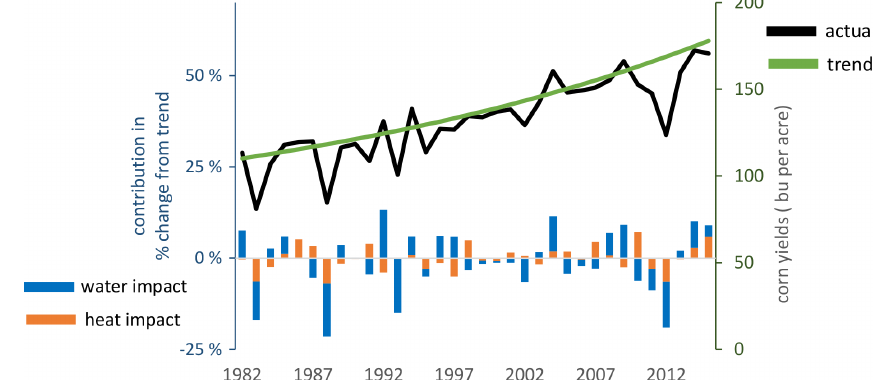
Figure 7. The bars show the contribution of water and contribution of heat in variation in the US corn yields (left axis). The lines illustrate actual yields and trend (right